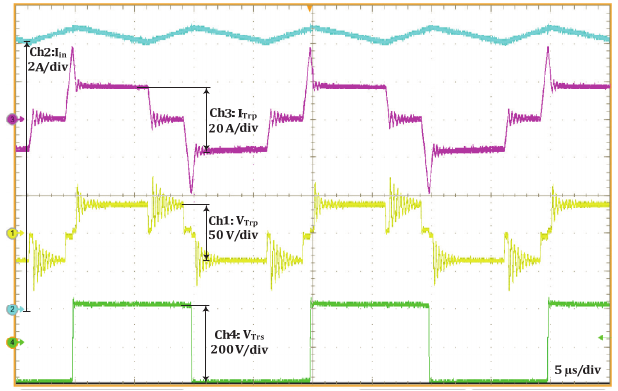
Fig. 7. Experimental waveforms of an ASMC converter: Ch1 – V Trp , Ch2 – I in , Ch3 – I Trp and Ch4 – V Trs